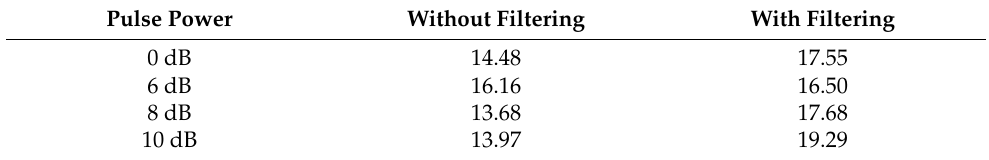
Table 3. SNR (dB) values for different pulse powers with and without filtering for defect depth 10%. Pulse Power